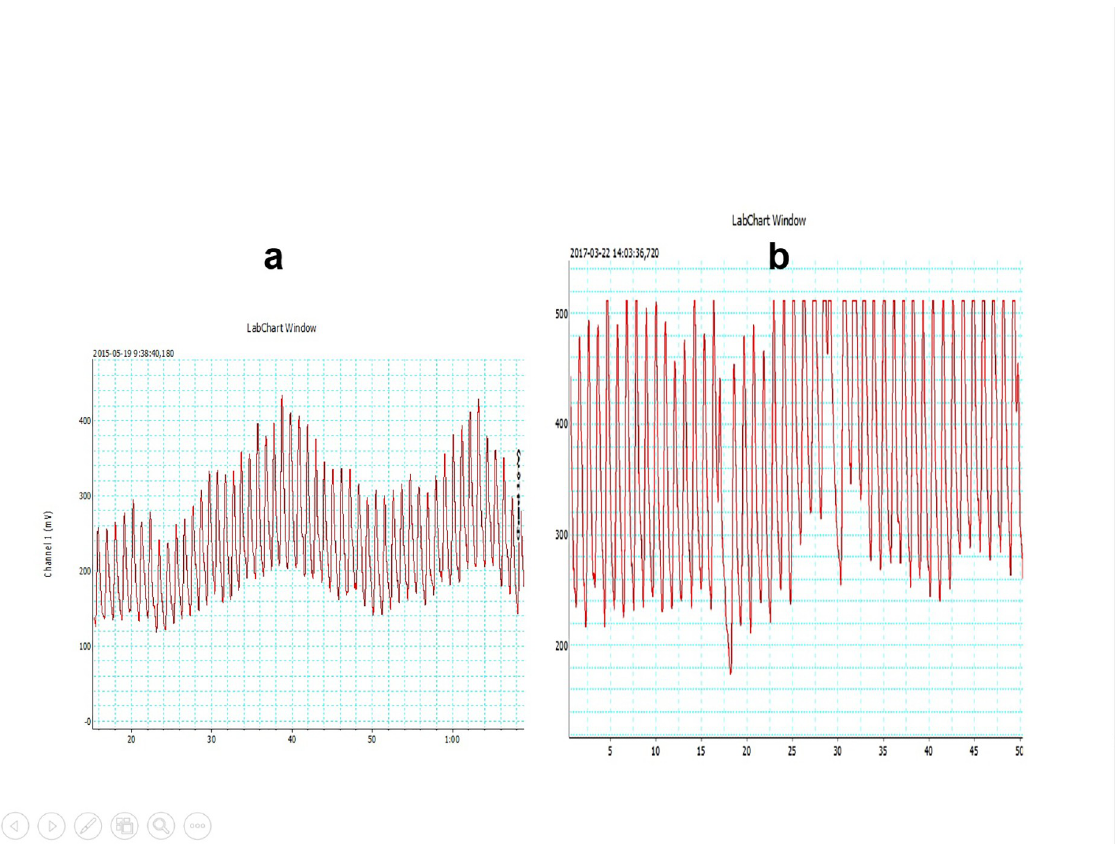
Fig 10. Laser Doppler recording of the big toe capillary flow velocity (in millivolts) in a patient with occlusion of the superficial femoral artery not suitable for reconstruction after 2 years of the applied arterial assist. a-before and b- after long-term assist. Pre- and post-IPC recording scales adjusted. Although the amplitudes before therapy were high there was an evident increase following the long-term assist.